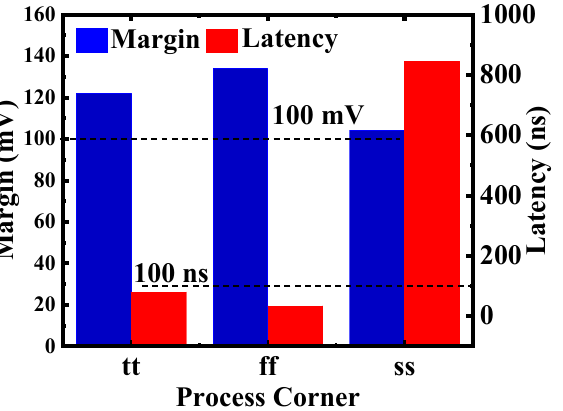
Figure 19. Minimum margin of the neighboring states and maximum latency time under different process corners in the X(N)OR mode.